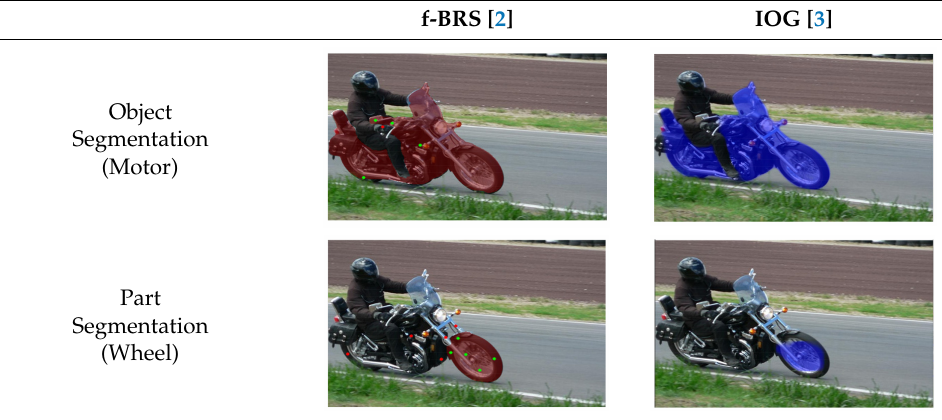
Table 1. The results of estimated masks for segmenting motorcycle (object) and wheel